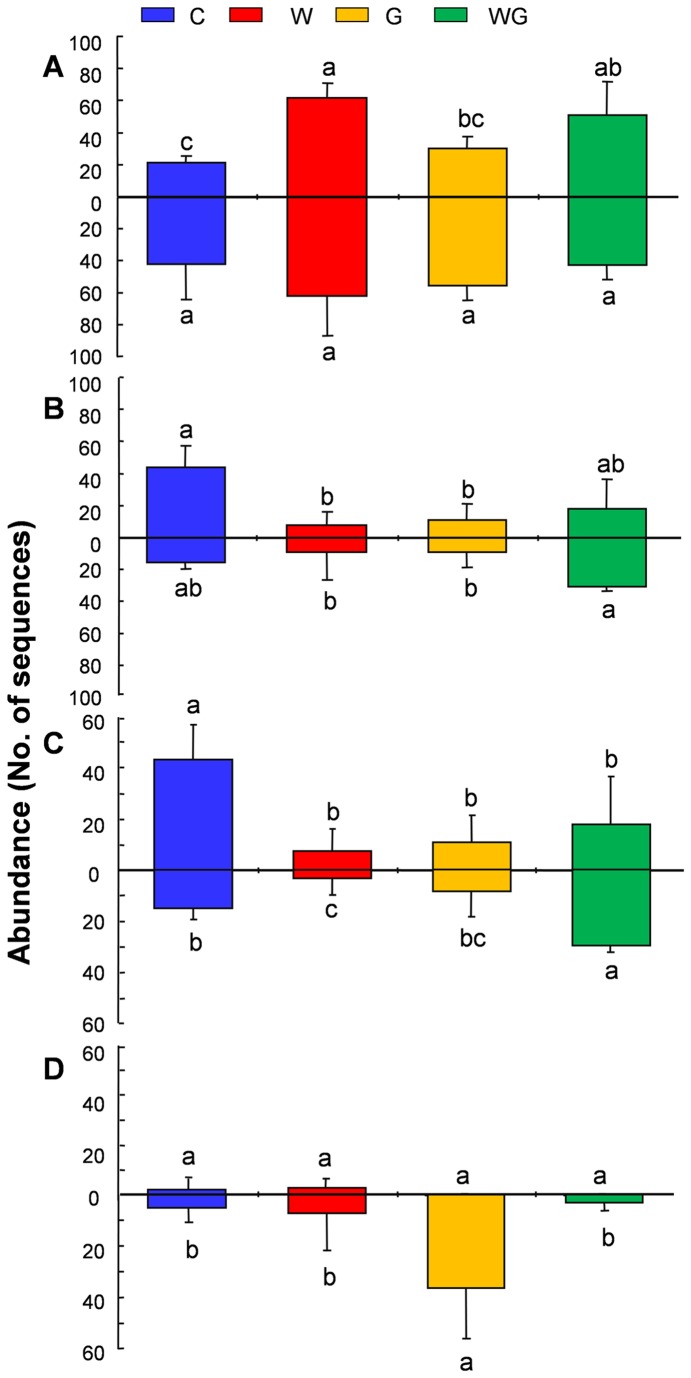
Abundance of common families and OTUs in soil and roots among the four treatments.A: Glomeraceae in soil (above X-axis) and roots (below X-axis); B: Gigasporaceae in soil (above X-axis) and roots (below X-axis); C: OTU25 in soil (above X-axis) and roots (below X-axis); D: OTU27 in soil (above X-axis) and roots (below X-axis). Bars without shared letters indicate significant differences at P < 0.05. Bars are standard deviations of the means (n = 4). Abbreviations: C, no-warming with no-grazing; W, warming with no-grazing; G, no-warming with grazing; WG, warming with grazing.